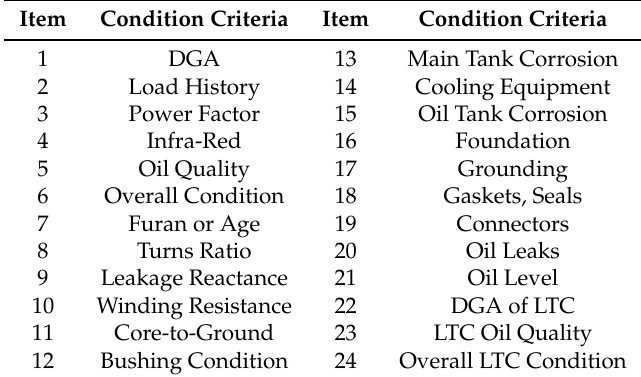
Table 1. Parameters of the transformer health index